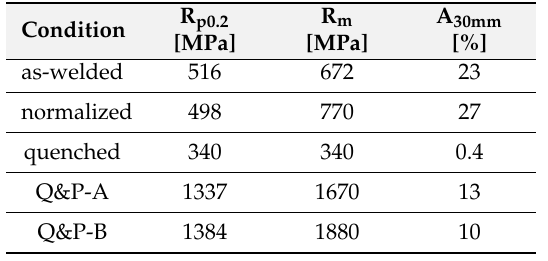
Table 3. Mechanical properties obtained by tensile testing.